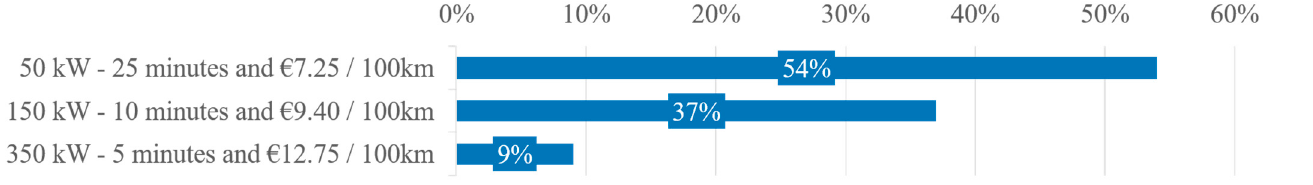
Figure 7. Preferences for primary charging ( n = 2977; own diagram based on [8]).